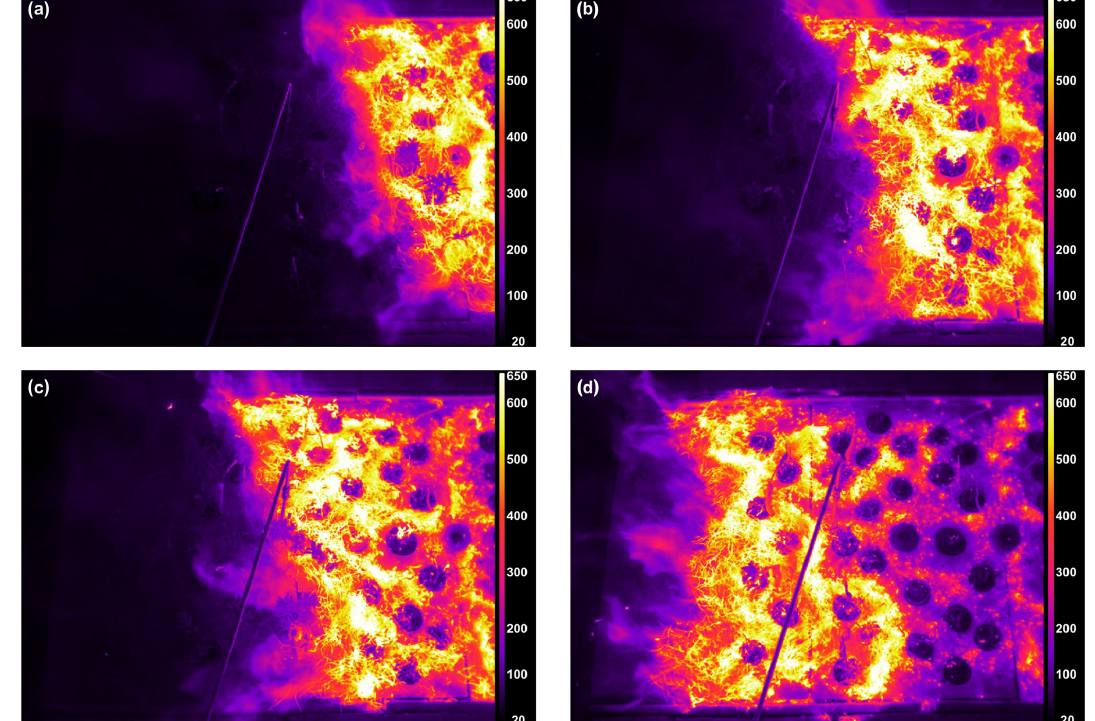
Figure 3. Burn 87 with inkberry on a longleaf pine needle fuel bed, with FLIR thermal imaging for burn progression. (a) Frame corresponding to FTIR scan 5 signaling the pre-combustion phase, (b) frame corresponding to FTIR scan 16 with the flame front nearing the sample probe, (c) frame corresponding to FTIR scan 21 with inkberry bush consumed by flame, and (d) frame corresponding to FTIR scan 44 in which the flame front has passed the probe. Dark circles are ceramic plant holders. The temperature scale is seen on the right